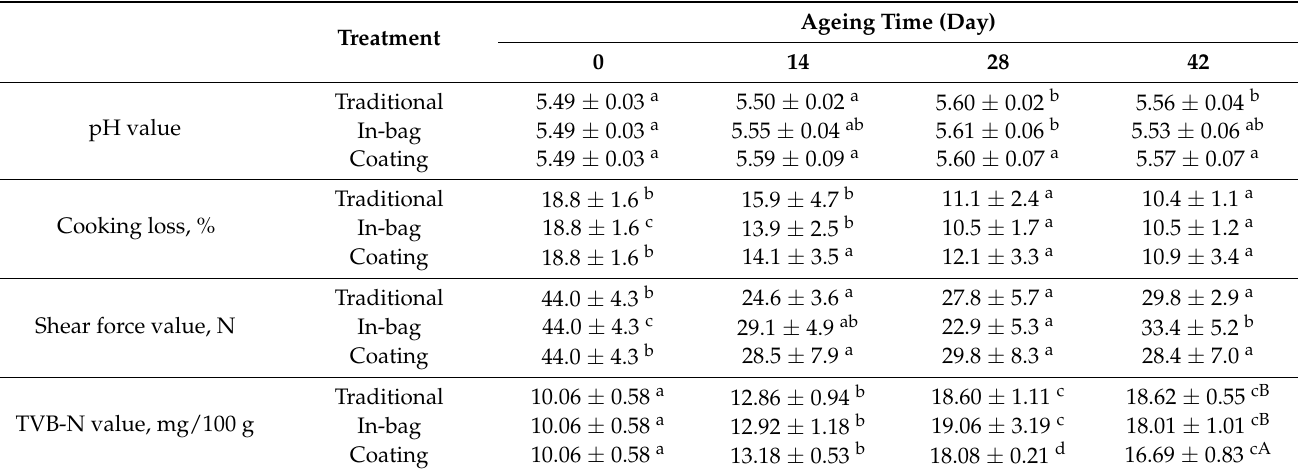
Table 1. Effects of different treatments on pH value, cooking loss, shear force value, and TVB-N value of beef during